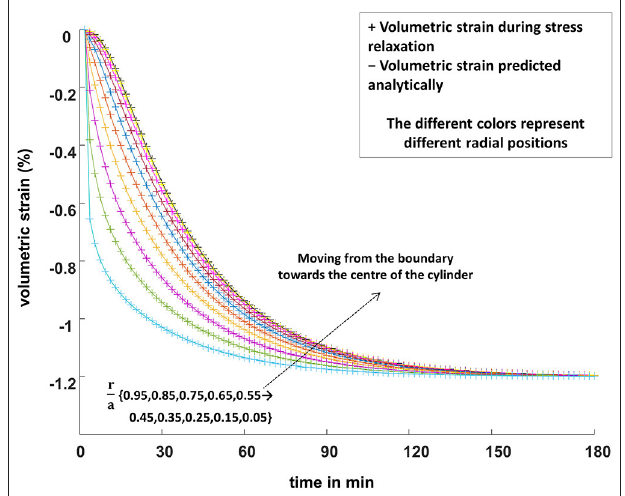
FIGURE 8 | The FEM predictions of the spatially varying volumetric strain (“ + ” symbols) inside a cylindrical poroelastic sample subjected to a constant compressive axial strain, undergoing stress relaxation, are plotted along with the analytical predictions (Equation 12; solid lines). Similar to the strain-relaxation case in Figure 7 , the volumetric strain decreases most quickly at the larger values of the radial position r where the fluid path out of the sample is shorter. The different colors represent different radial positions, r/a : cyan 0.95, lime 0.85, purple 0.75, yellow 0.65, orange 0.55, blue 0.45, brown 0.35, magenta 0.25, yellow 0.15, and olive